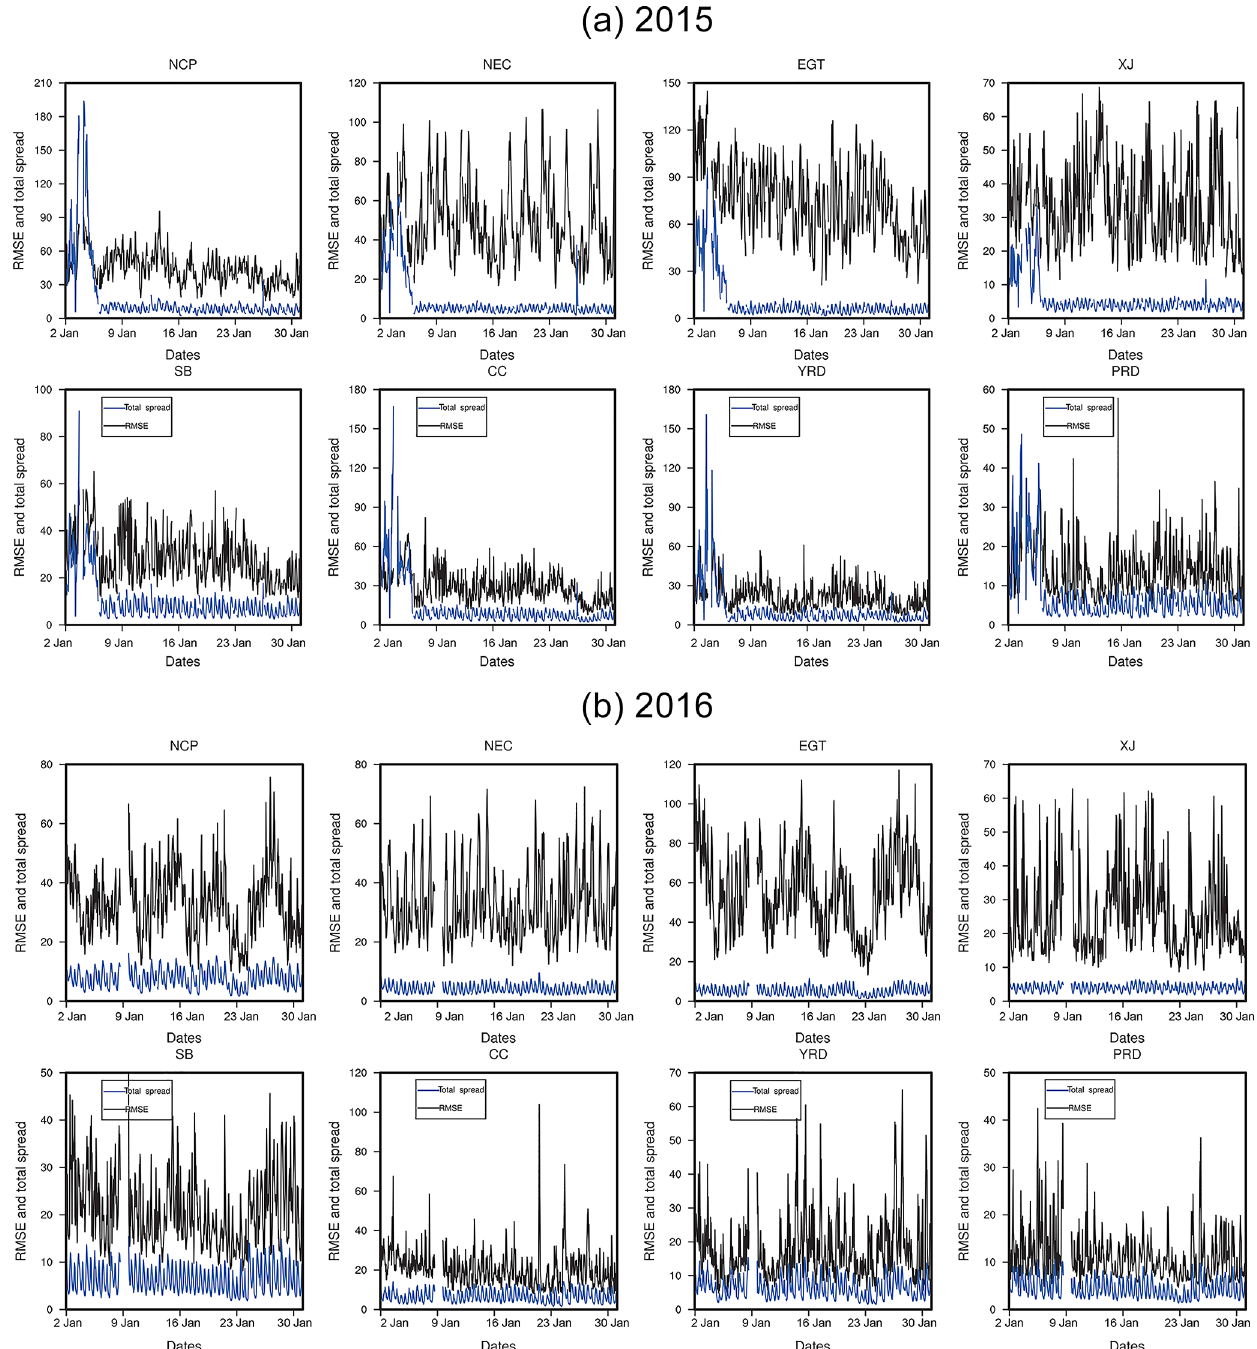
Figure 6. Regional averaged RMSE and the total spread for (a) January 2015 and (b) January 2016 in eight regions. Time starts from 00:00UTC. (Units: µgm − 3